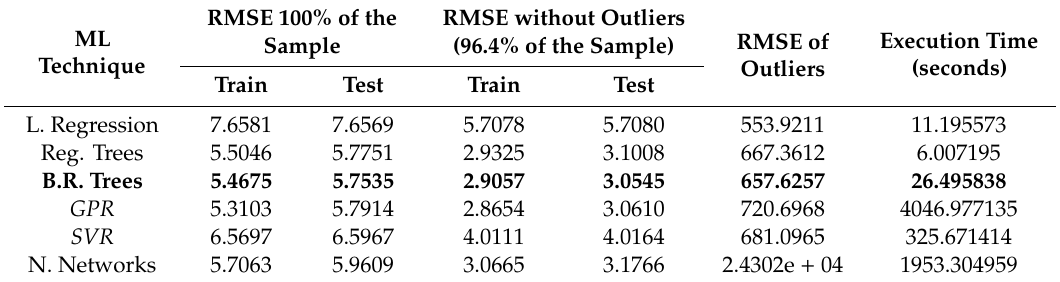
Table 14. SSDE-CTDI VOL results for Skull protocol.